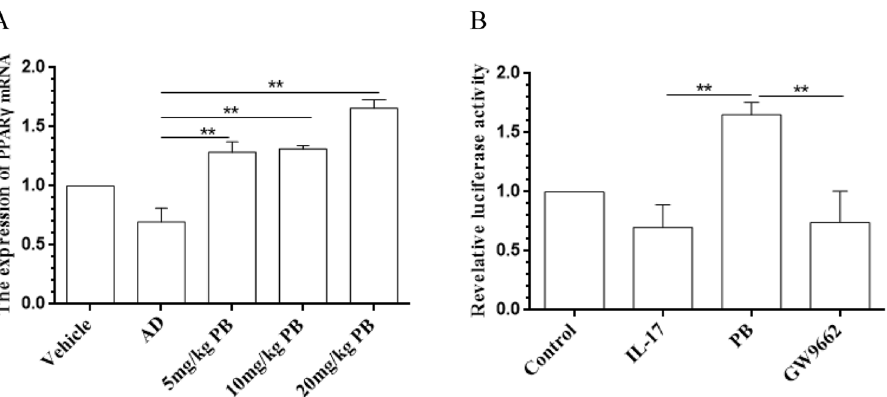
Figure 7. Enhancement of PB on PPAR γ expression and activation. ( A ) The expression of PPAR γ mRNA in the lesional skin tissues of NC/Nga mice was measured by qRT-PCR. Data are representative of two independent experiments and presented as mean ± SD of n = 8 mice per group. Vehicle, intact mice with saline treatment; AD, DNFB-sensitized and challenged mice; PB, pseudolaric acid B. ( B ) Induction of a luciferase reporter gene following ligand-dependent activation of a PPAR γ fusion receptor in transiently transfected RAW264.7 cells as described in methods. The luciferase activity was measured and normalized by Renilla luciferase expression vector. Data are presented as mean ± SD. Each measurement was performed in duplicate and all experiments were repeated three times. ** P <